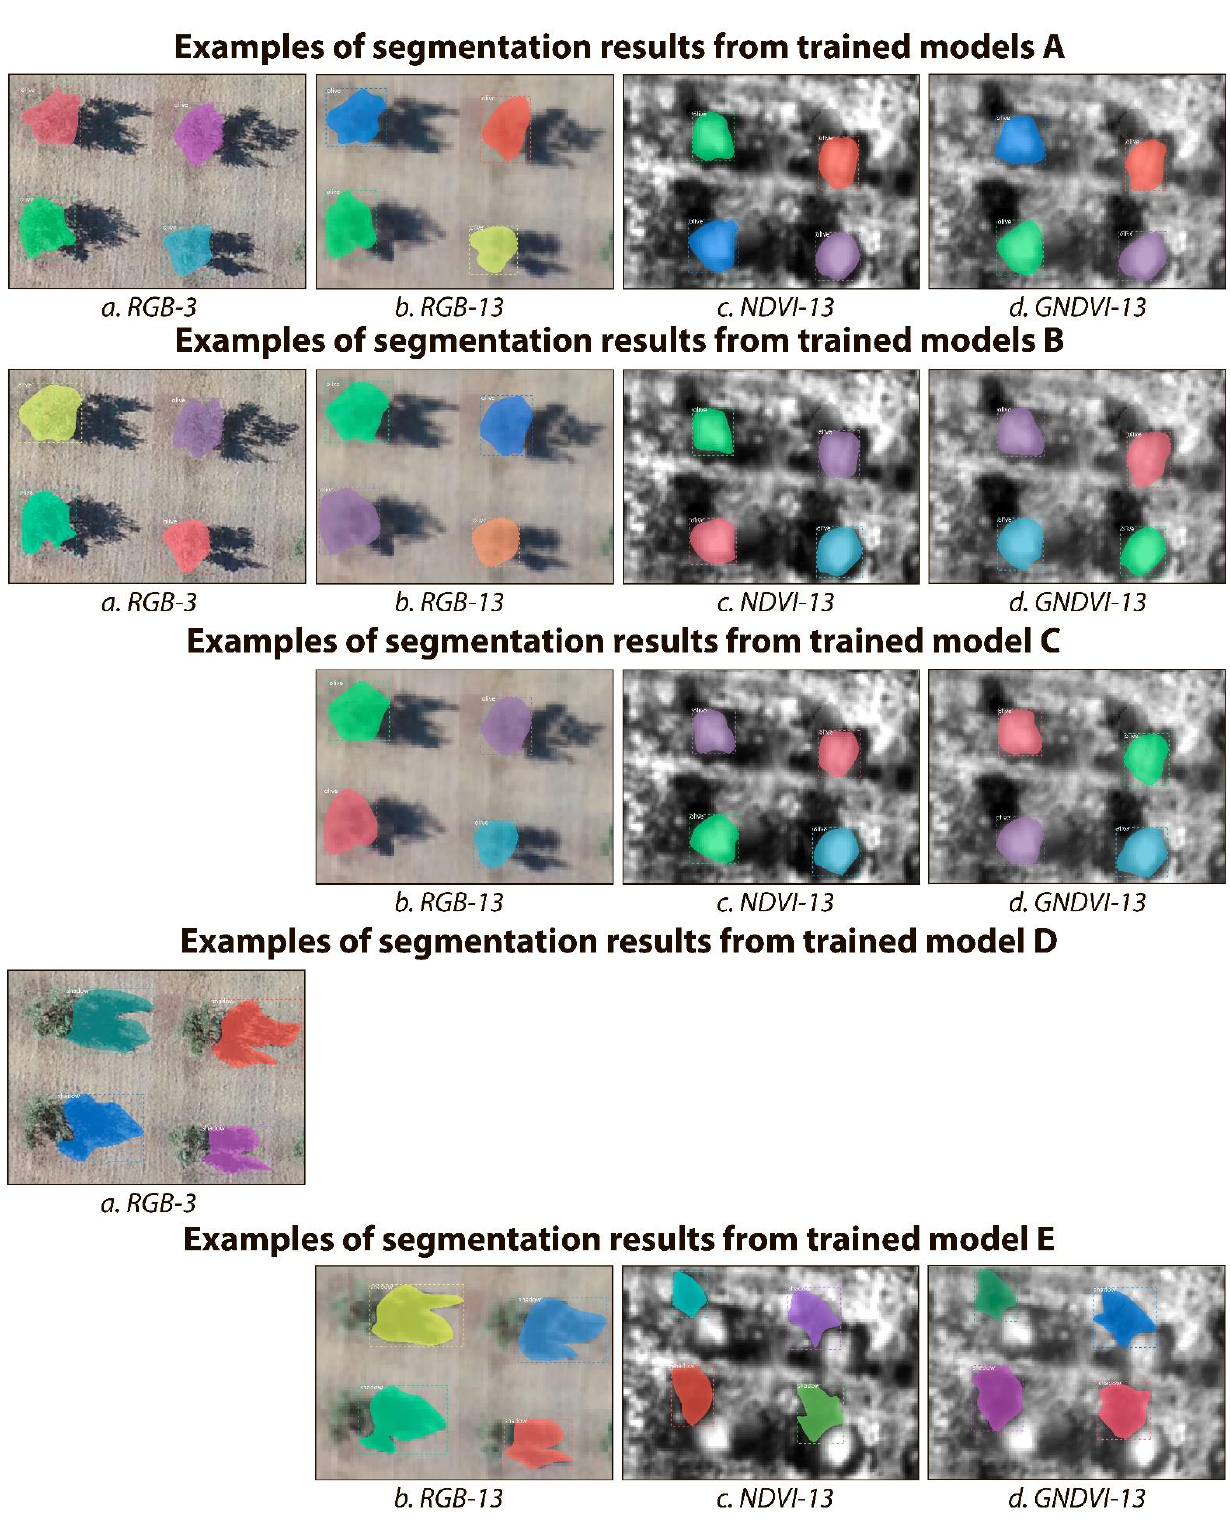
Figure 6. Examples of the segmentation results for the class “Olive tree crowns” (models A, B and C) and for the class “Olive tree shadows” (models D and E) using Mask R-CNN in the four image subsets of the OTCSS-dataset. See Section 3.4. Experimental Setup for model explanation. The testing datasets were: ( a ) RGB-3 cm/pixel, ( b ) RGB-13 cm/pixel, ( c ) NDVI-13 cm/pixel and ( d ) GNDVI-13 cm/pixel. RGB: Red, Green, Blue; NDVI: normalized difference vegetation index; GNDVI: green normalized difference vegetation index.